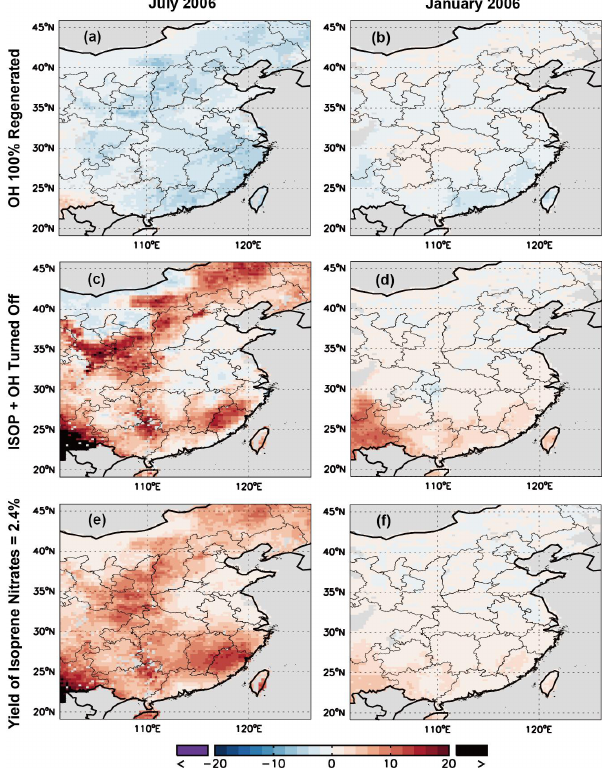
Fig. 9. Spatial distribution of percentage differences between mod- eled NO 2 columns with and without adjustments in the organic chemistry. (a, b) The OH is assumed to be 100% regenerated from the reaction of isoprene + OH. (c, d) The isoprene + OH reaction is turned off. (e, f) The net yield of isoprene nitrates is assumed to be 2.4% instead of the default